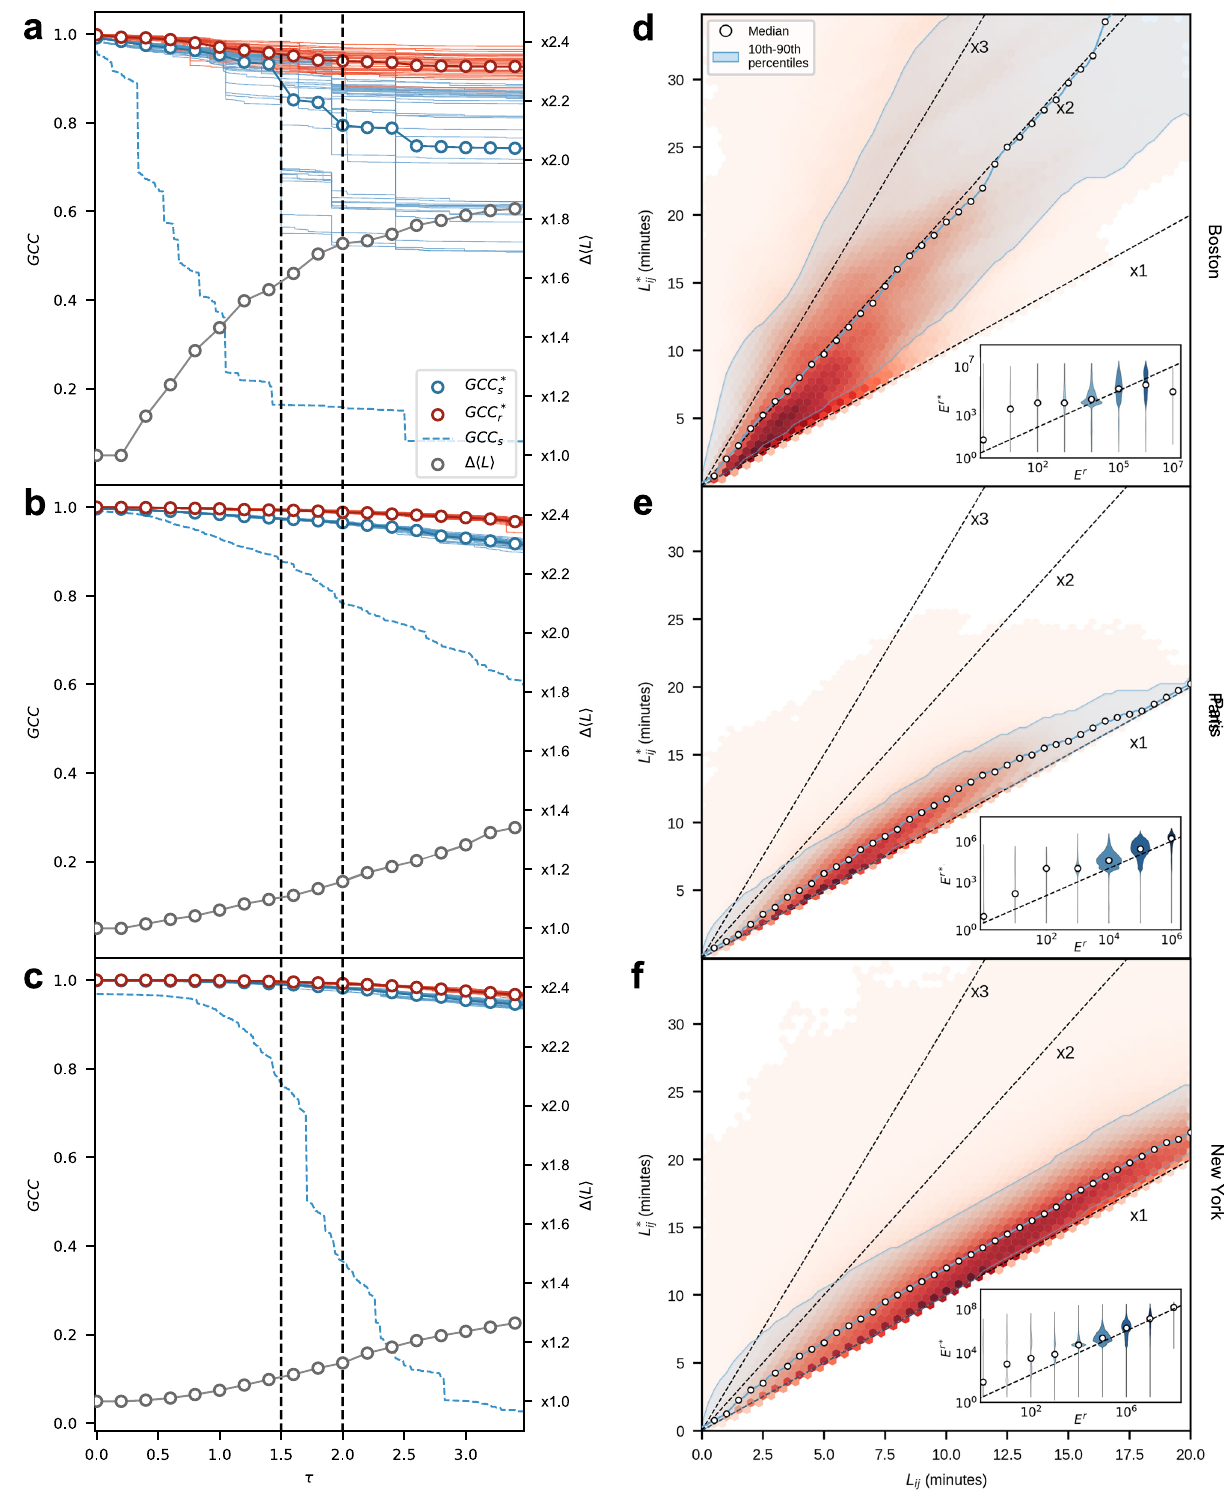
Fig. 4 Results of the Open Streets shared-effort heuristic. As can be seen in ( a ), ( b ), and ( c ), applying the process to Boston, New York City and Paris leads to signi fi cant gains for the sidewalk network with respect to the case of no intervention (blue dashed line). In addition, the road network begins to lose some connectivity as higher-width sidewalks are pedestrianised, but these losses are relatively small. The ( d ), ( e ) and ( f ) show the distribution of the increase in average path lengths (in minutes) for drivers when the process has been run up to sidewalks of 5 m in width. While removed streets from the road network clearly implies longer travel times for cars, these plots show quite forcefully that the costs are relatively low and concentrated around short- to-medium paths. Figure insets analyse the effects the heuristic has on the betweenness of roads, E r corresponds to the initial betweenness value and E r * to the road betweenness after the heuristic has been